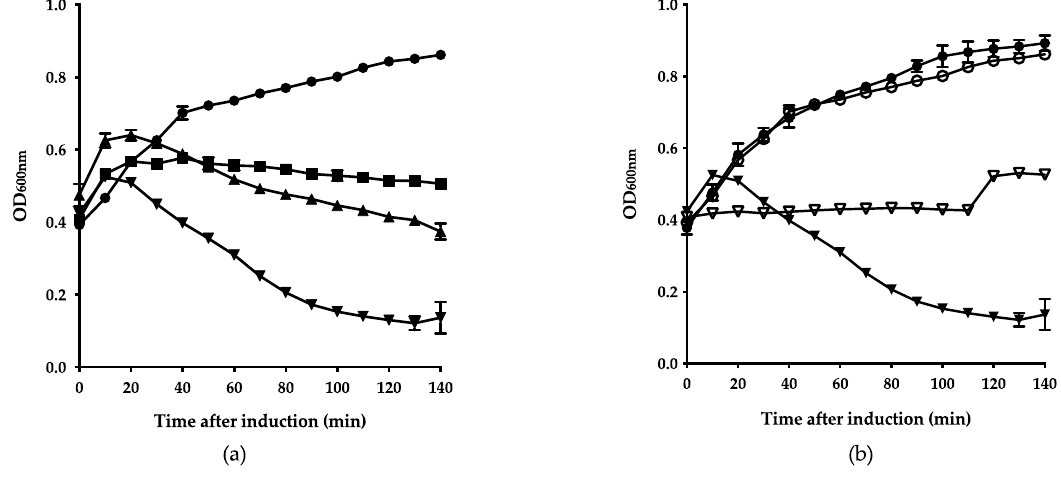
Figure 3. Fletchervirus phage F352 endolysin uses the Sec-pathway to access the periplasm, followed by activation by the holin. ( a ) Growth of E. coli cells expressing predicted lytic proteins. Optical density (OD 600 ) of cells expressing endolysin ( ); holin ( ▲ ) and co-expression of endolysin and holin ( ▼ ) was compared to E. coli cells carrying empty vector ( ● ). ( b ) Dependence of predicted endolysin on the Sec-pathway. To investigate the dependence of the endolysin on the Sec-system, cells expressing the endolysin and holin were cultured in the presence of sodium azide (NaN3) ( ▽ ) or absence ( ▼ ). The growth of cells carrying the empty vector with ( ○ ) and without ( ● ) NaN 3 served as negative controls.